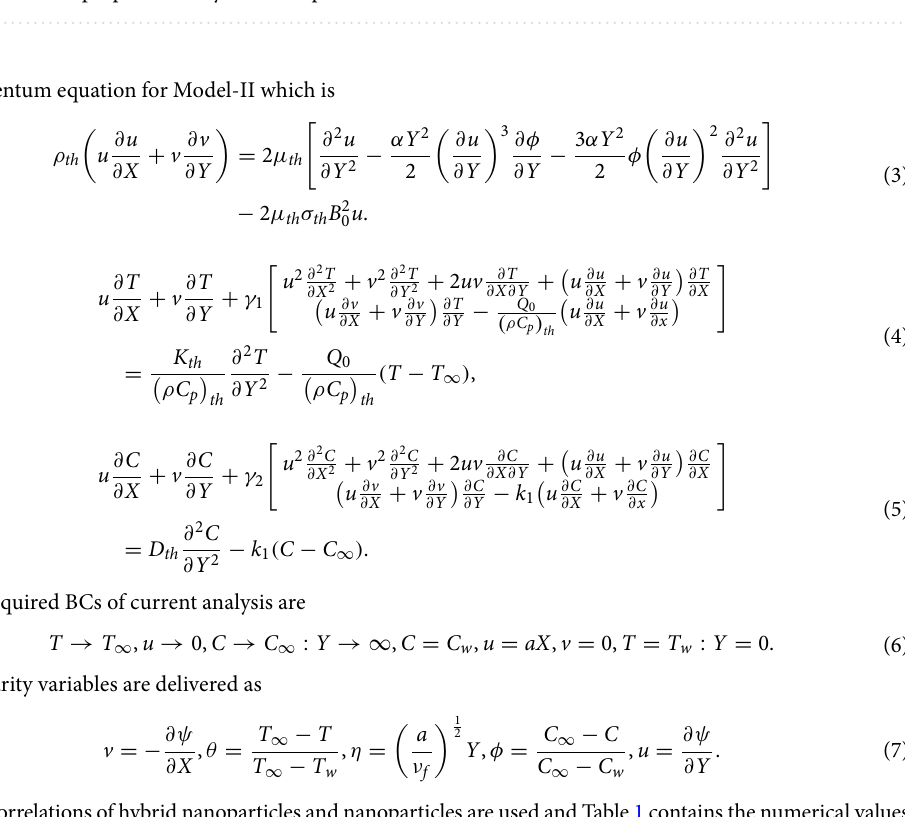
Table 1. Thermal properties of hybrid nanoparticles with base